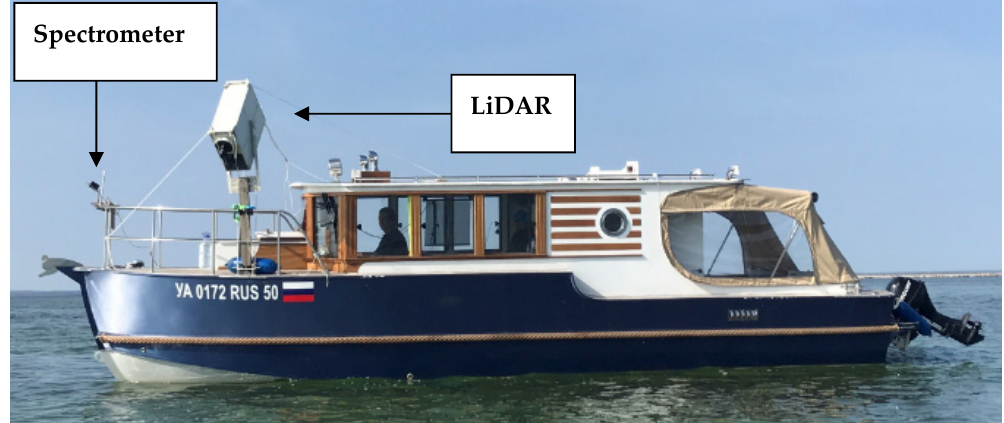
Figure 4. The spectrometer and LiDAR positions onboard a high-speed gliding motorboat.